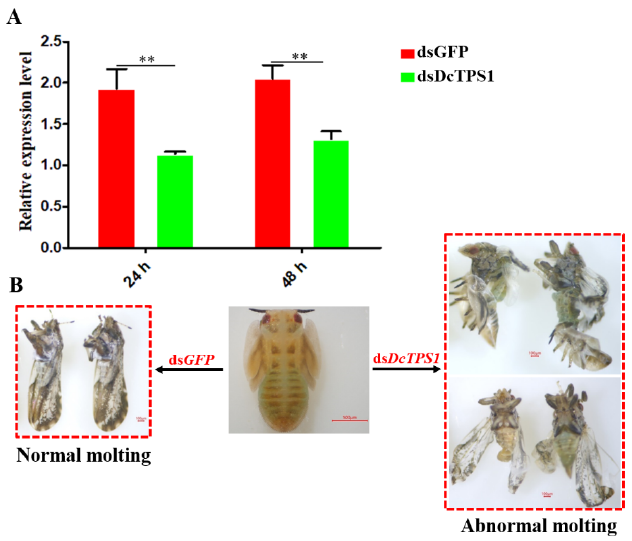
Figure 4. Detection of DcTPS1 expression levels and phenotypic observation after treatment with ds DcTPS1 and ds GFP . ( A ) Analysis of DcTPS1 expression levels after treatment with ds DcTPS1 and ds GFP . The 2 −∆∆ Ct method was adopted to calculate the relative expression level. The SPSS software was used to conduct statistical analysis. The asterisks indicate the significance differences by ** p < 0.01. ( B ) Phenotypic observation of D. citri adult at 48 h.